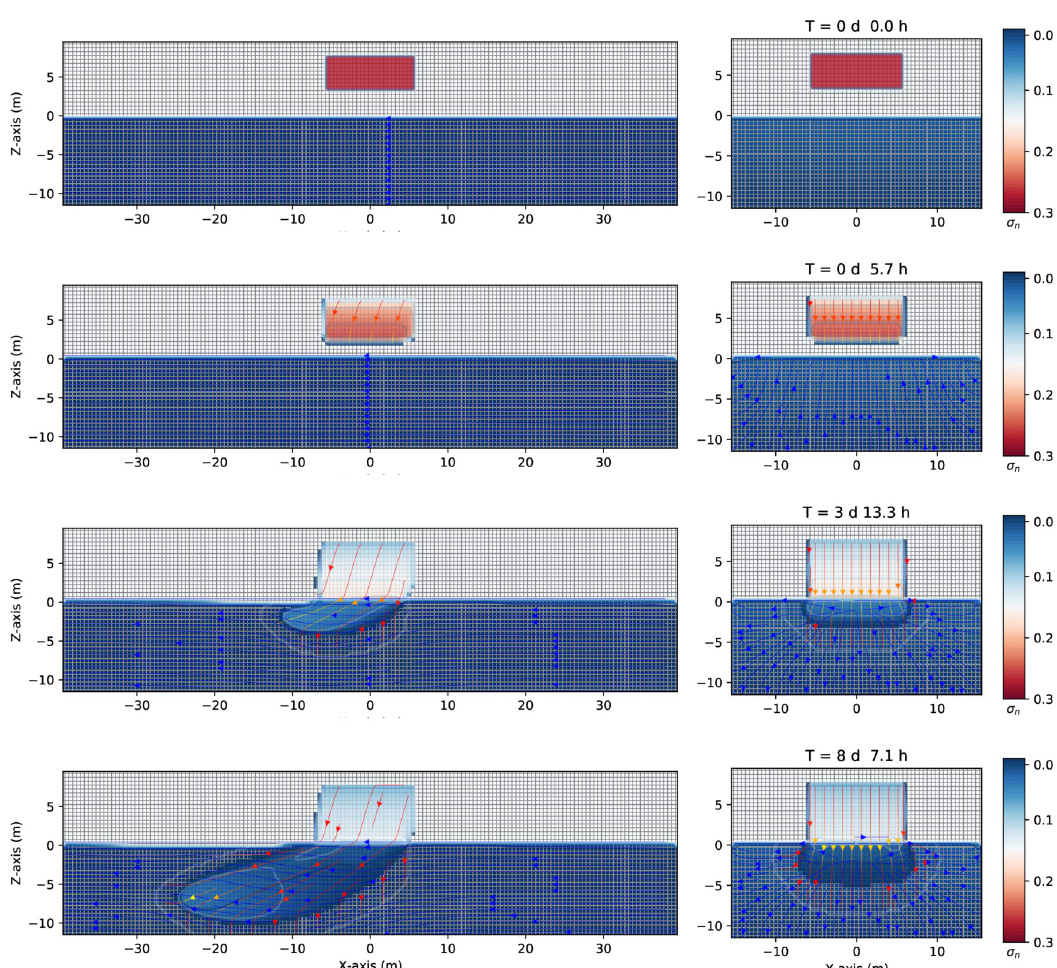
Fig 8. Saturation contours of DNAPL (small source) at different times. Three-dimensional numerical simulation results of the saturation contours ( σ = S ) of a three-phase immiscible fluid flow (water + a small volume source of DNAPL + air) using a spatial n n ϕ grid resolution of 0.50 m and a grid dimension of 80 m × 32 m × 22 m , at different times. Left-hand side shows the saturation contours in the ( z − x ) plane. Right-hand side shows the saturation contours in the ( z − y ) one. Notice how the DNAPL migrates through the saturated zone while moving in the left direction (where it is positioned a gravity at 15 degrees in the z–x plane, left- hand side) at different